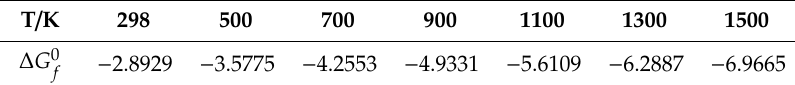
Table 1. Gibbs free energy of carbon under di ff erent temperatures.